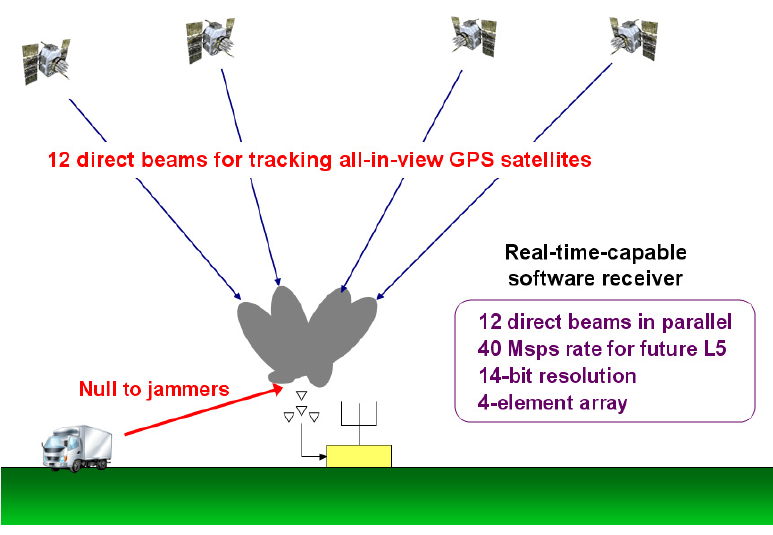
Figure 1. Illustration of the functionality of our GPS SDR for processing a four-elememt controlled reception pattern antenna (CRPA) array. The receiver adaptively rejects jammers while steering high gains toward all GPS satellites in